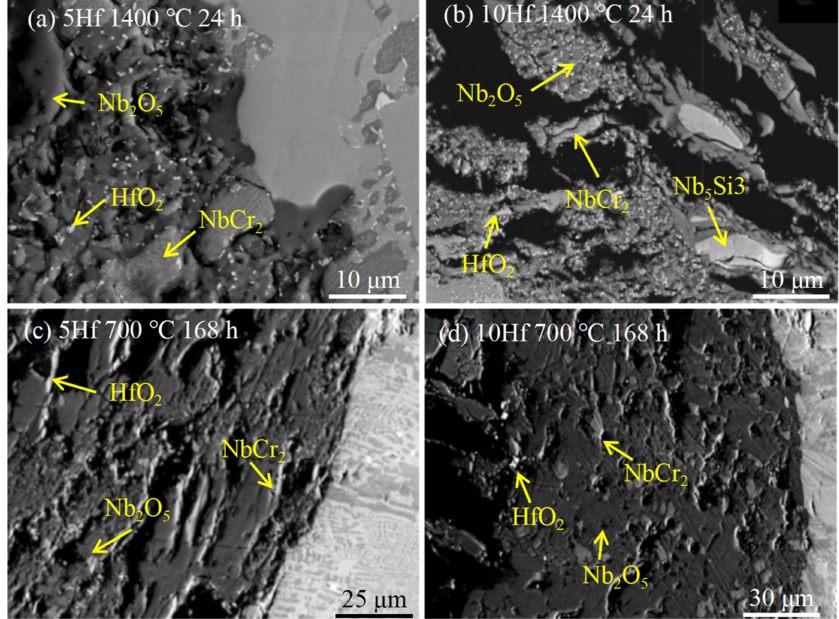
Figure 3. Microstructure of Nb-20Cr-20Si-5Hf alloy ( a , c ) and Nb-20Cr-20Si-10Hf alloy ( b , d ) after short-term oxidation at 1400 ◦ C and long-term oxidation at 700 ◦ C. Copyright 2011 Elsevier.